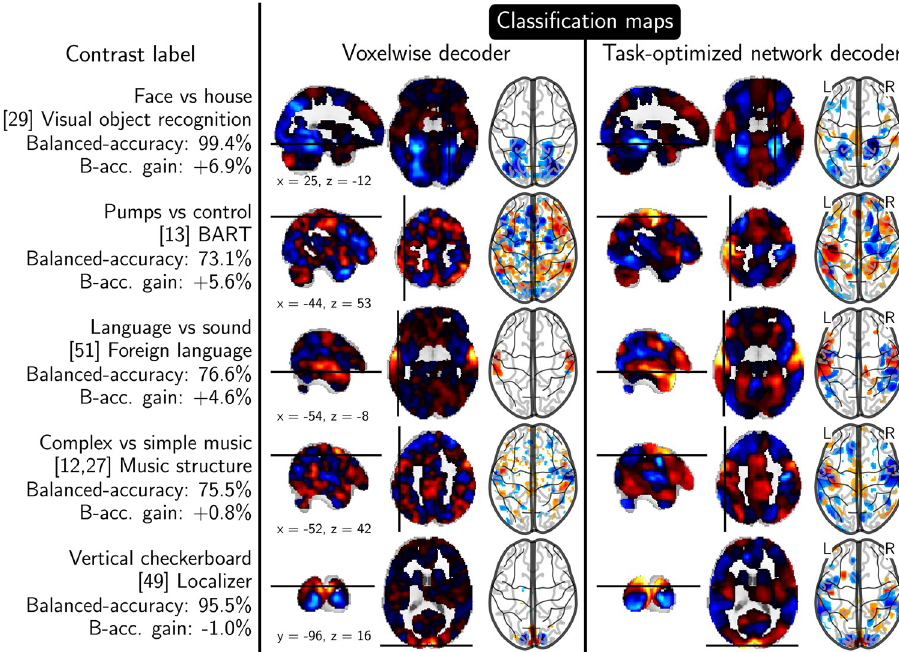
Fig 6. Classification maps obtained from multi-study decoding (right). The maps are smoother and more focused on functional modules than when decoding from voxels (left). For contrasts for which there is a performance boost (top of the figure), relevant brain regions are better delineated, as clearly visible on the face vs house visual-recognition opposition, in which the fusiform gyrus stands out better. B-acc stands for balanced accuracy using multi-study decoding (see